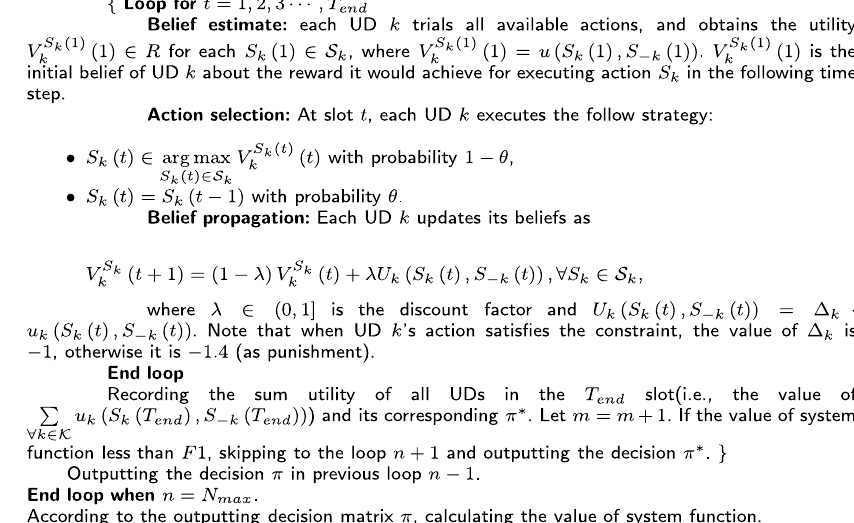
where N max is the maximum iteration times of the outer